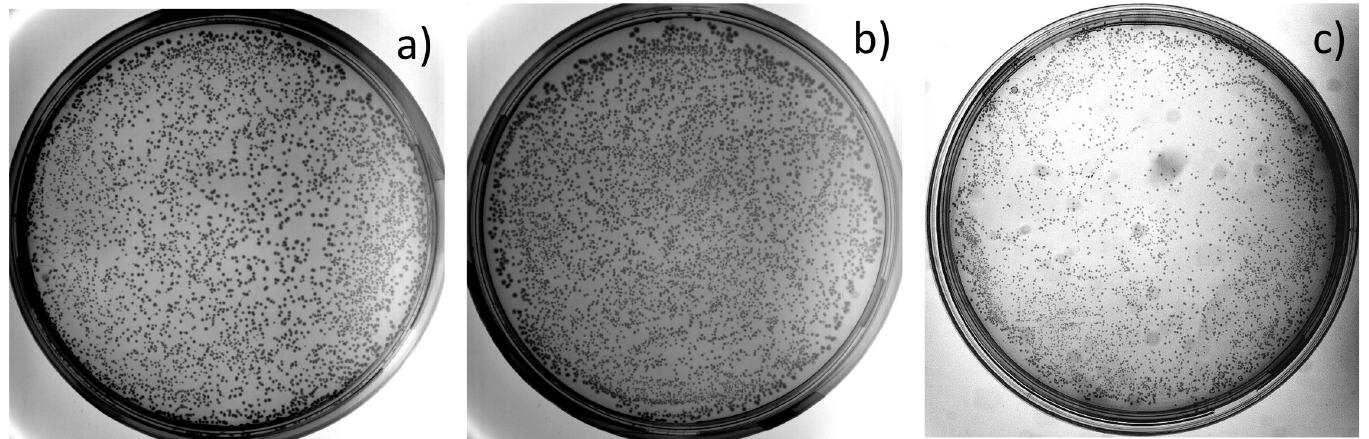
Fig 4. Photographic pictures of the 8.8 mm diameter petri dish with the selective Amp+ media containing colonies of the E . coli Dh5 α strain transformed with the circularized product. a) Whole circular plasmid amplification (WPA) (3 802 colonies), b) OverFlapPCR-based whole plasmid amplification (OverFlapWPA) (4 534 colonies), and c) OverFlapPCR-based asymmetric whole plasmid amplification (OverFlapAsymWPA) (4 865 colonies). All the procedures were completed as described in the Materials and methods section.